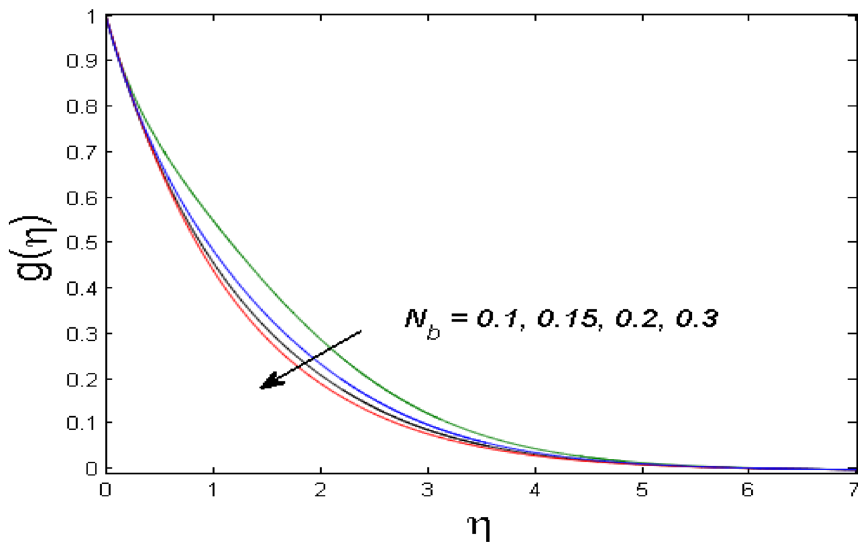
Figure 11. g (η) versus varied estimates of N b .